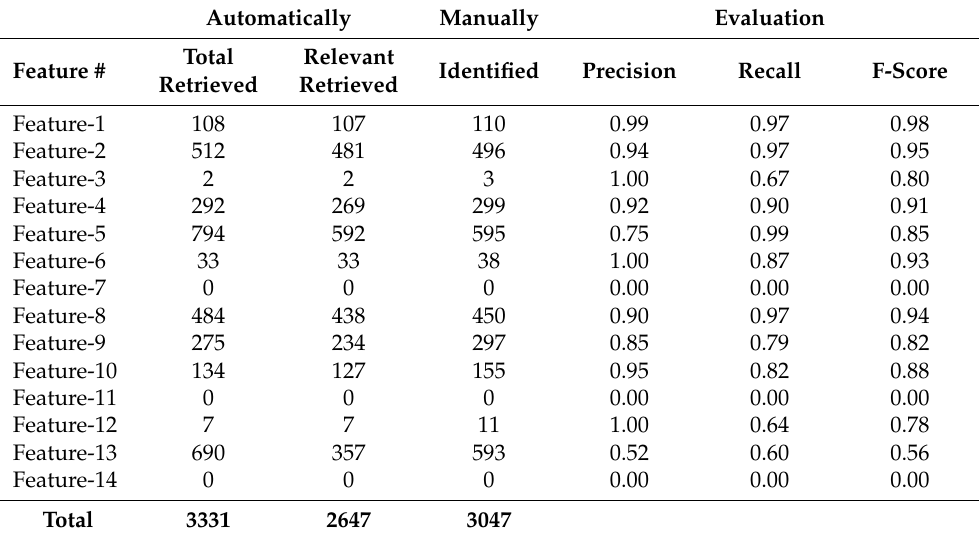
Table 7. Comparison of rule-based feature words extraction with manual extraction.